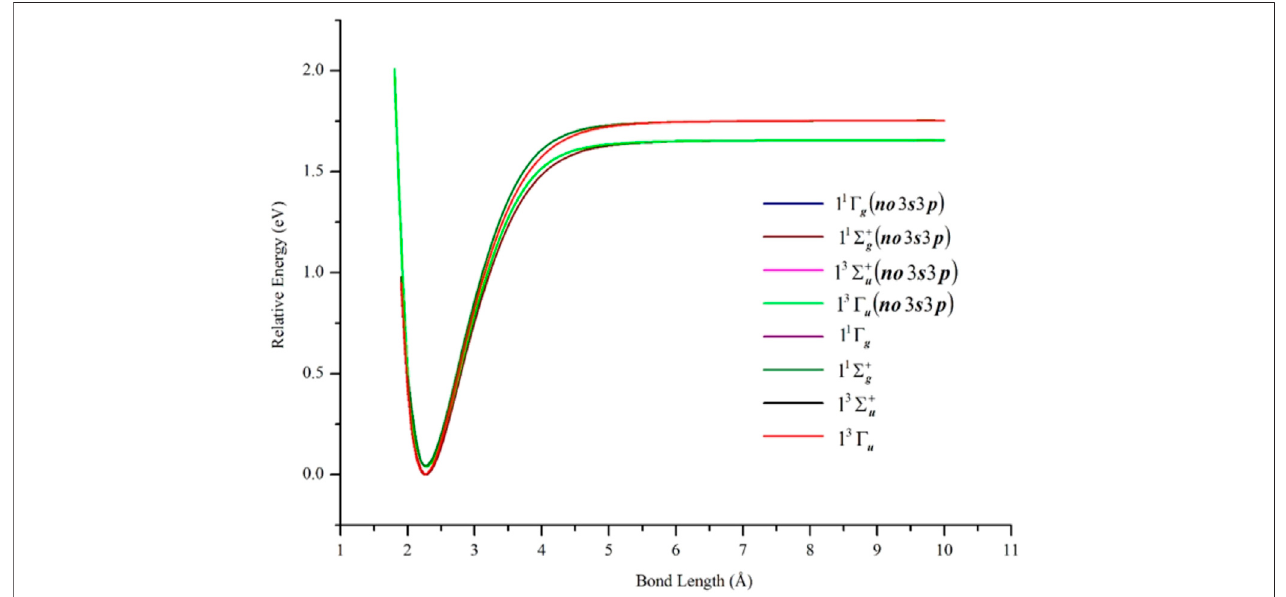
FIGURE 3 | PECs of low-lying δδ – hole electronic states of Ni 2 computed at the GVVPT2 level of theory, with and without the correlation of 3s3p semi-core electrons, using the cc-pVTZ basis set. All energies are plotted relative to the lowest energy value of the ground X 1 Γ g term.